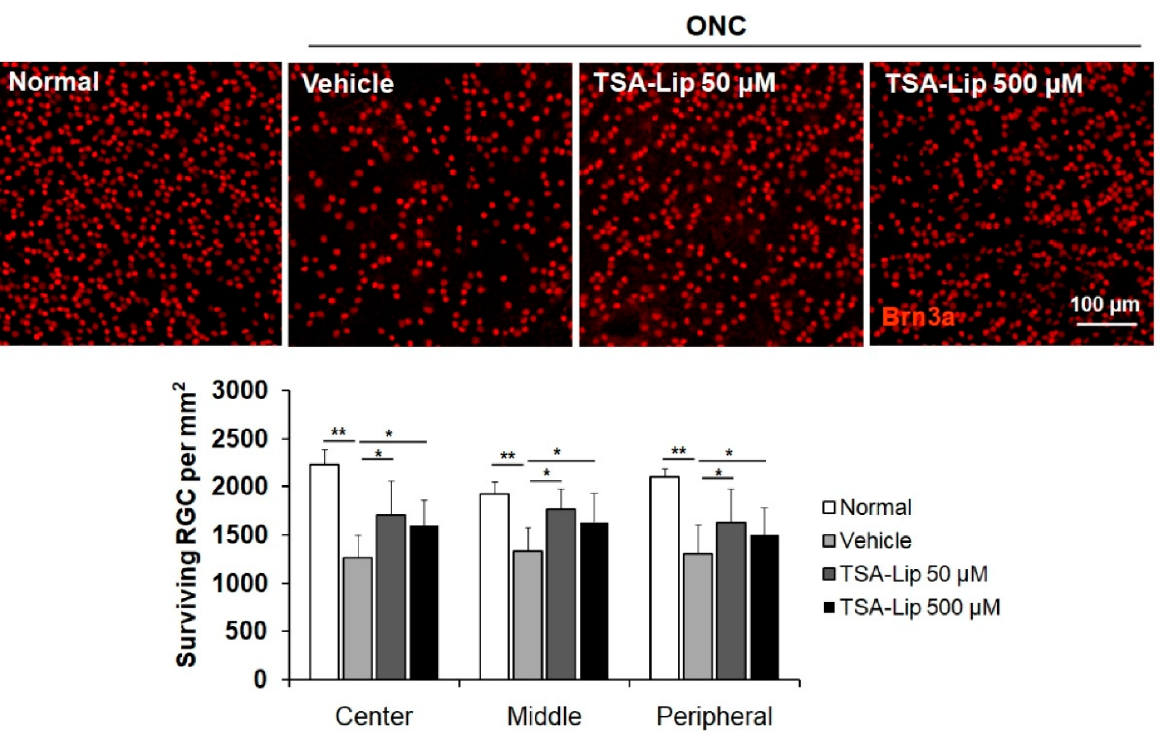
Figure 6. Effect of trichostatin A-loaded liposomes on RGC survival after ONC. Retinal flat mounts are shown for the uninjured normal retinas, vehicle-injected retinas, and retinas injected with 50 µ M and 500 µ M trichostatin A-loaded liposomes ( n = 5 retinas per group). A quantitative analysis of RGC survival in center, middle, and peripheral zones of each retinal quadrant is also shown as a graph. Trichostatin A-liposomes 50 µ M = liposomes loaded with 50 µ M trichostatin A; trichostatin A-liposomes 500 µ M = liposomes loaded with 500 µ M trichostatin A. Scale bar = 100 µ m; ** p < 0.001, compared to the uninjured normal retina; * p < 0.05 compared to the vehicle-injected retina; one-way ANOVA with post hoc LSD test. Reproduced with permission from Sung et al.